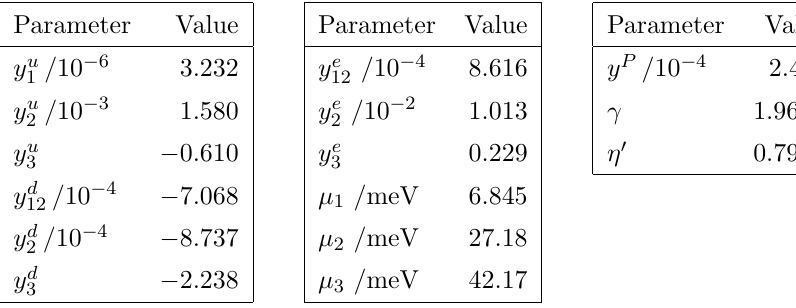
Table 5. Best (cid:12)t input parameter values. The model has 13 real parameters: y u y P and two additional free phases: (cid:17) 0 and (cid:13) . The total (cid:31) 2 is